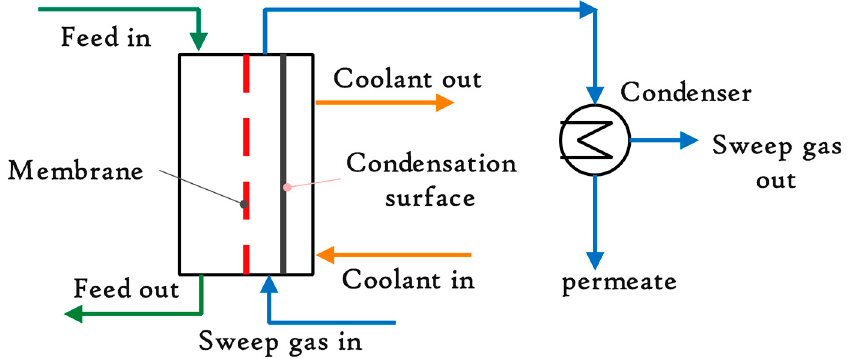
Figure 4. Schematic diagram of thermostatic sweeping gas membrane distillation (TSGMD) [73] .